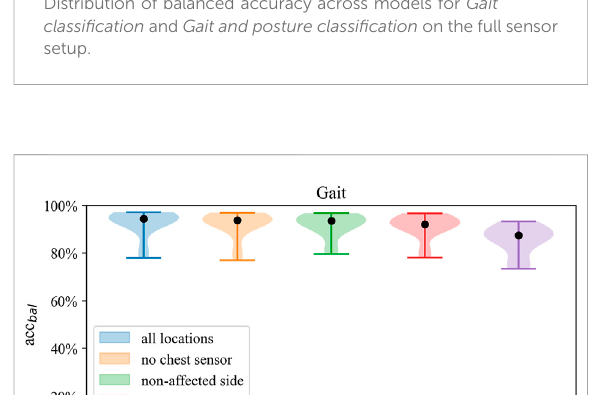
FIGURE 2 Distribution of balanced accuracy across models for Gait classi fi cation and Gait and posture classi fi cation on the full sensor